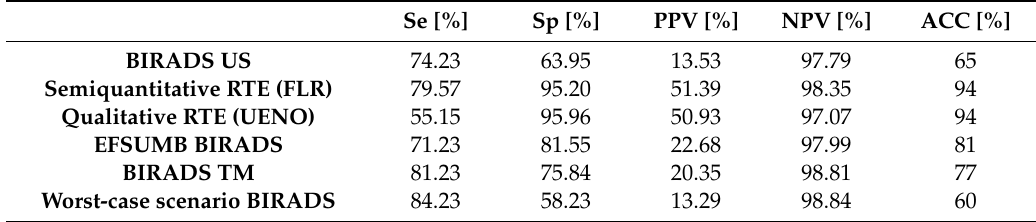
Table 7. Diagnostic value of proposed methods (1405 nodules).